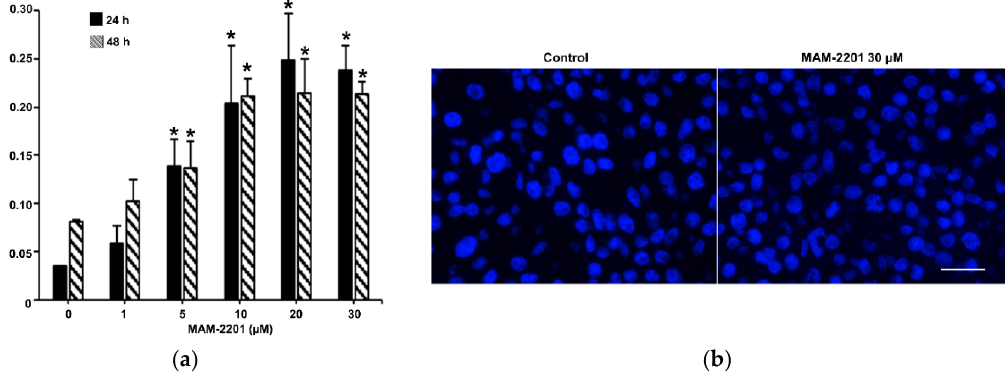
Figure 7. ( a ) Composite images showing the evaluation of caspase-3/7 activity and ( b ) apoptotic cells in D384 spheroid sections after MAM-2201 exposure. The caspase-3/7 activity was impaired: an increase in the activity levels was observed in D384 spheroids starting from 5 to 30 µM for both time points considered (24–48 h). Apoptotic cells detected using Hoechst 33,258 staining were not visible after 48 h of exposure to MAM-2201 at the highest concentration tested (30 µM). The data